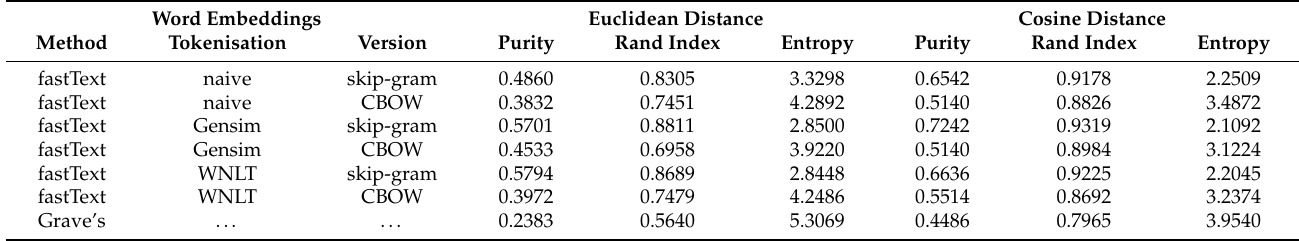
Table 4. The results for the concept categorisation task.